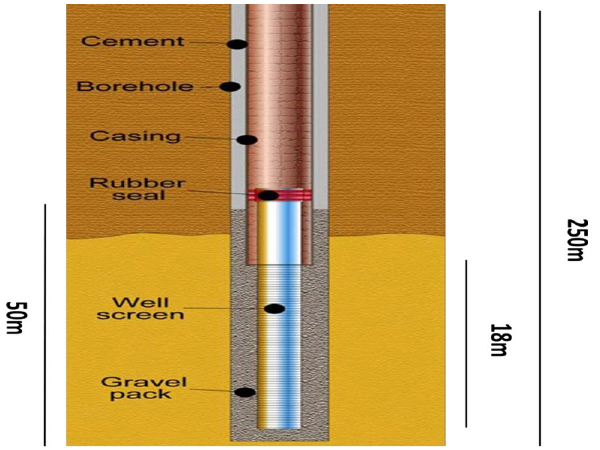
Fig. 12 Isopach map showing the depth extent of the polluted zone of Ikoyi–Victoria Island axis